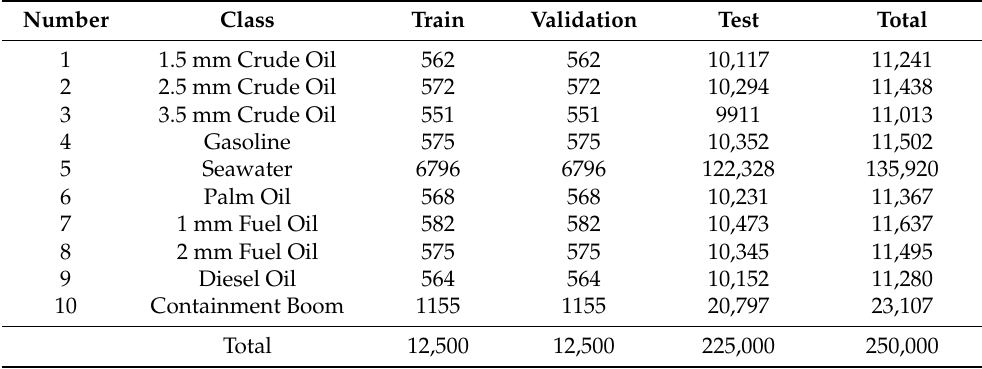
Table 2. Sample numbers of training, validation, and testing in the oil type data.